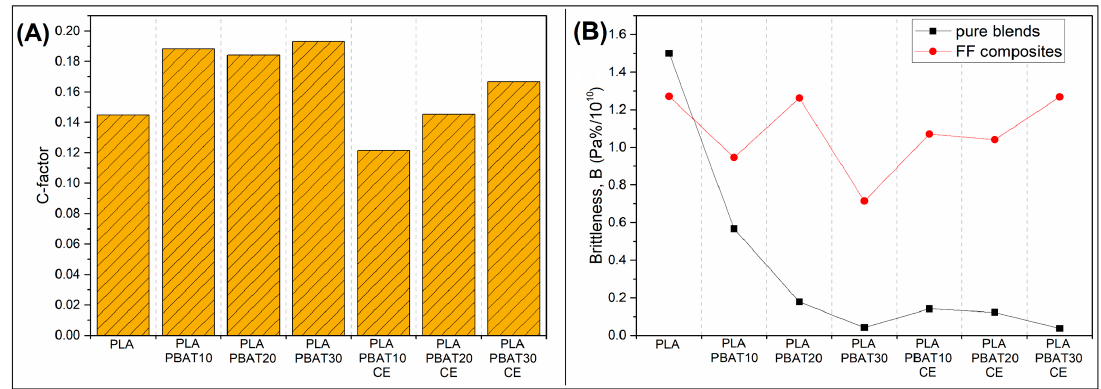
Figure 8. The comparison of ( A ) the C-factor values for FF reinforced composites, and ( B ) Brittleness coefficient values for injection molded blends and FF composites.